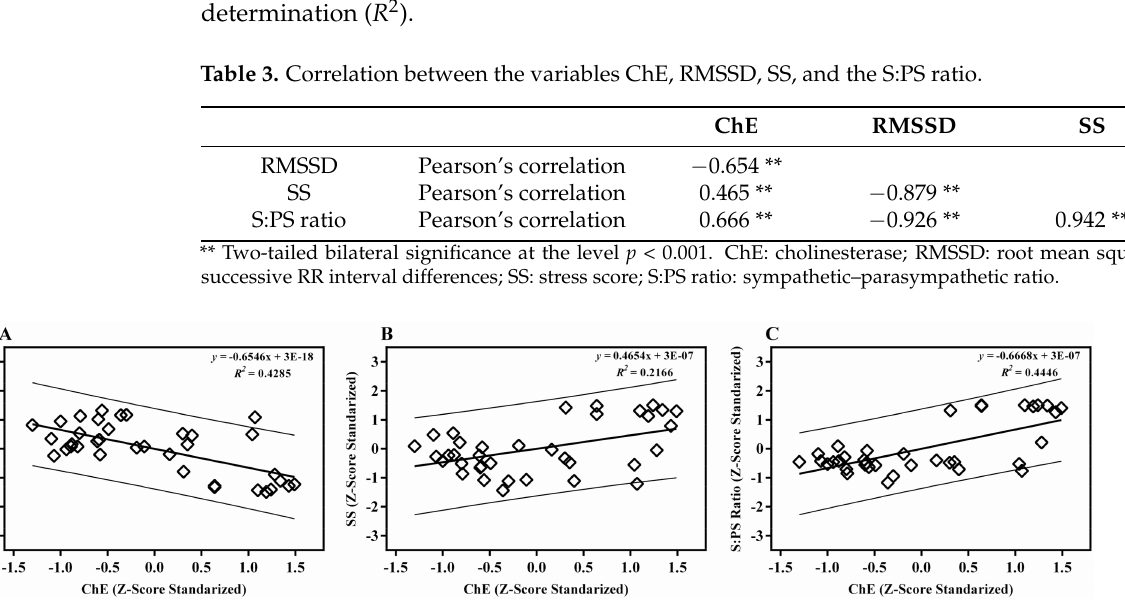
Figure 3. Correlation R 2 of the ChE with the root mean square of successive RR interval differences ( A ), the stress score ( B ), and the sympathetic/parasympathetic ratio ( C